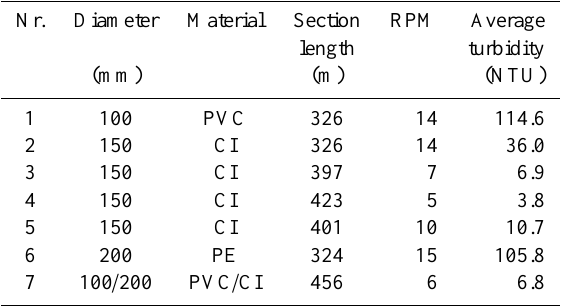
Table 2. The results of RPM ranking measured with Ultraturb equipment in the field study place (Fig.